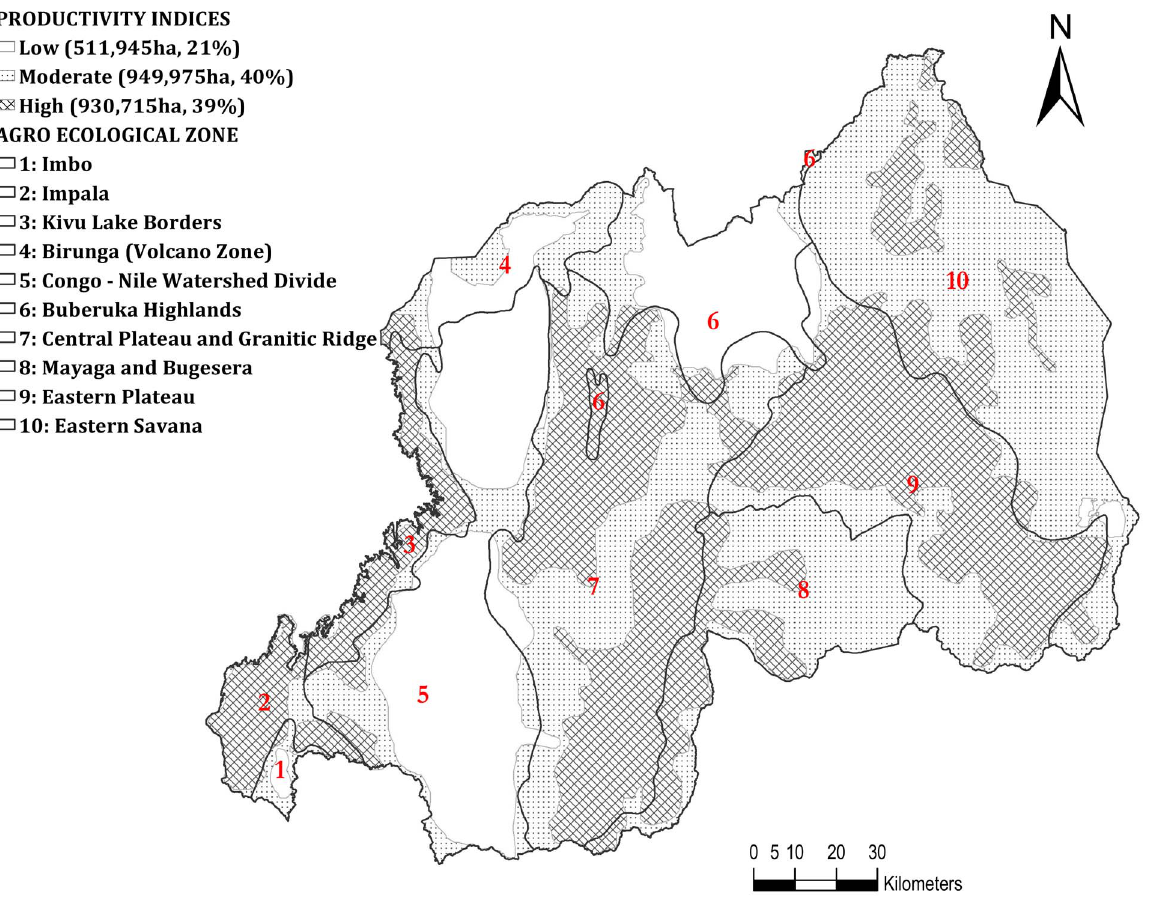
Figure 2. Qualitative Arabica coffee productivity indices (low, moderate, and high) generated by combining factors (elevation, slope, soil type, rainfall, and temperature) using weighted overlay analysis in the ten agro-ecological zones.